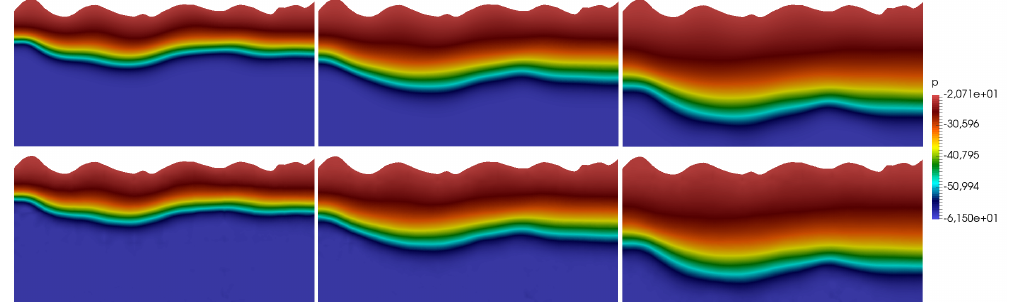
Figure 7. Numerical results for Test 1.DBC . Solutions p and p ms for different times: t 25 , t 50 , and t 100 (from left to right). First row: Fine-scale solution DOF f = 13,600. Second row: Multiscale solution using 16 basis functions DOF c =